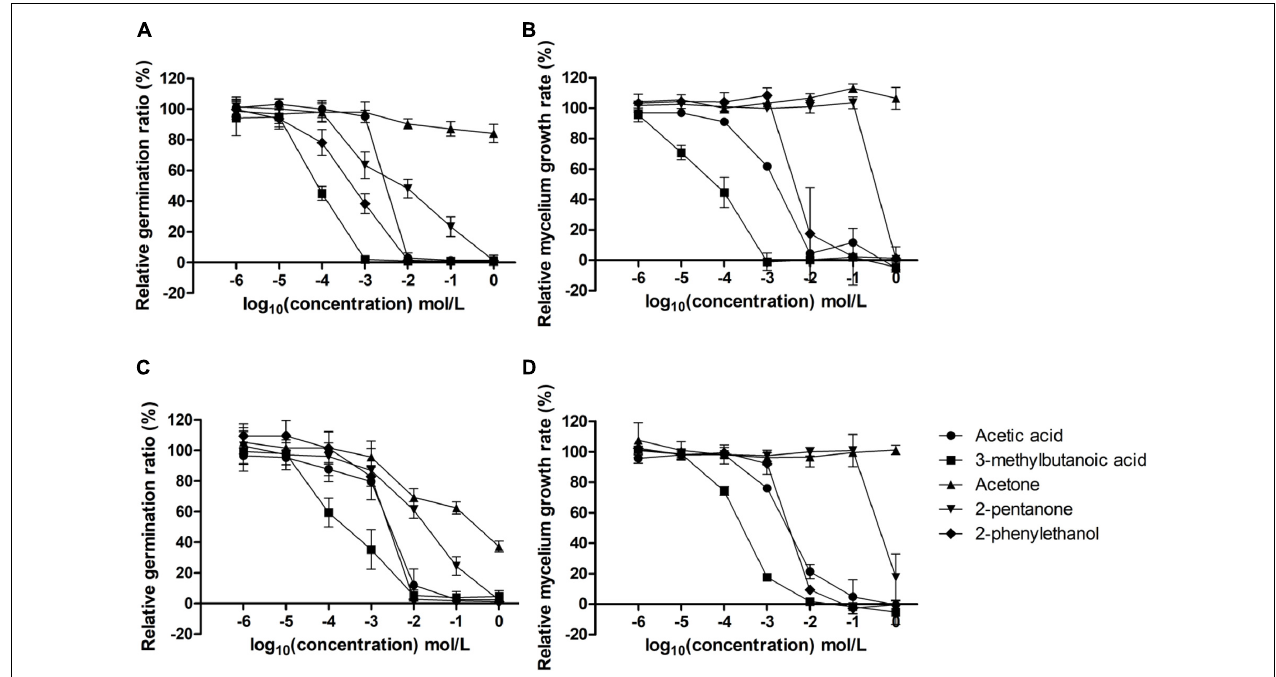
FIGURE 3 | Inhibitory effects of targeted single VOCs on germination ratios (%) of C. inversicolor (A) and P. roqueforti (C) and mycelium growth rates ( µ /h) of C. inversicolor (B) and P. roqueforti (D) at different concentrations (10 0 , 10 − 1 , 10 − 2 , 10 − 3 , 10 − 4 , 10 − 5 , and 10 − 6 mol/L). Each spot represents the mean value from three independent experiments, and the error bars represent the standard deviations.